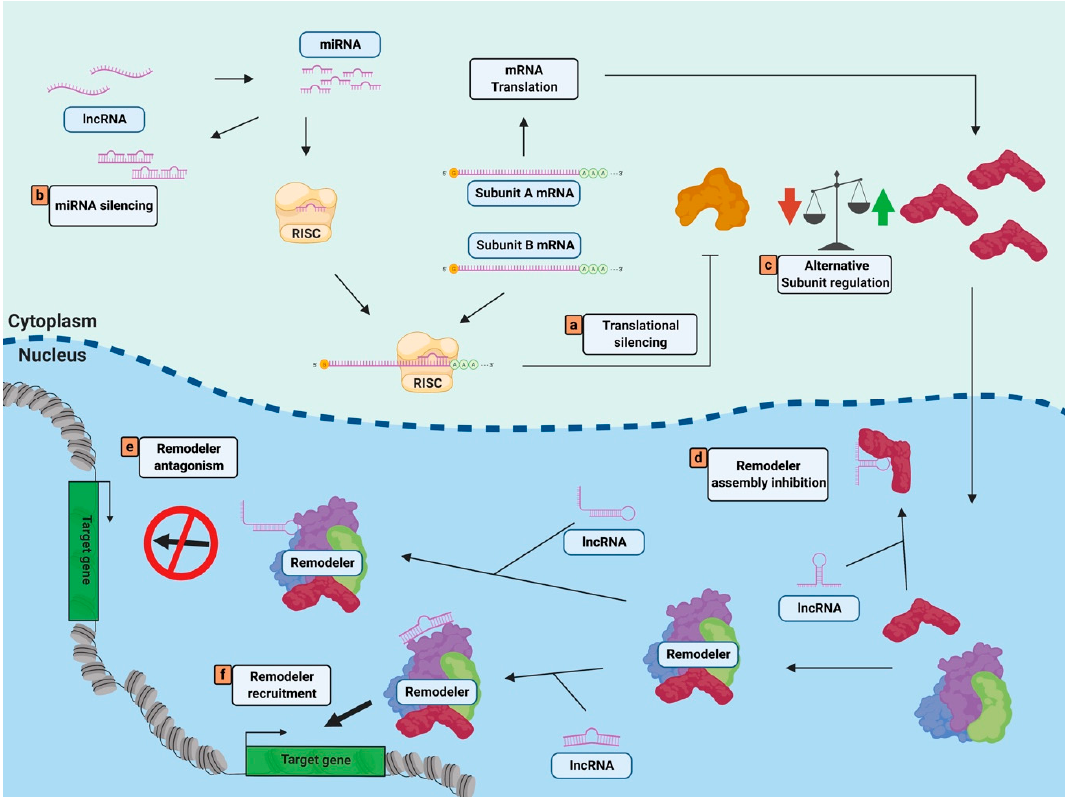
Figure 1. Examples of non-coding RNAs regulating nucleosome remodelers. (a–f) ncRNAs of various classes can regulate the activity of nucleosome remodelers pre-transcriptionally through (a) translational silencing, (b) miRNA silencing, or (c) alternative subunit regulation and post-transcriptionally through (d) remodeler assembly inhibition, (e) remodeler antagonism, or (f) remodeler recruitment. Figure created with Biorender.com.